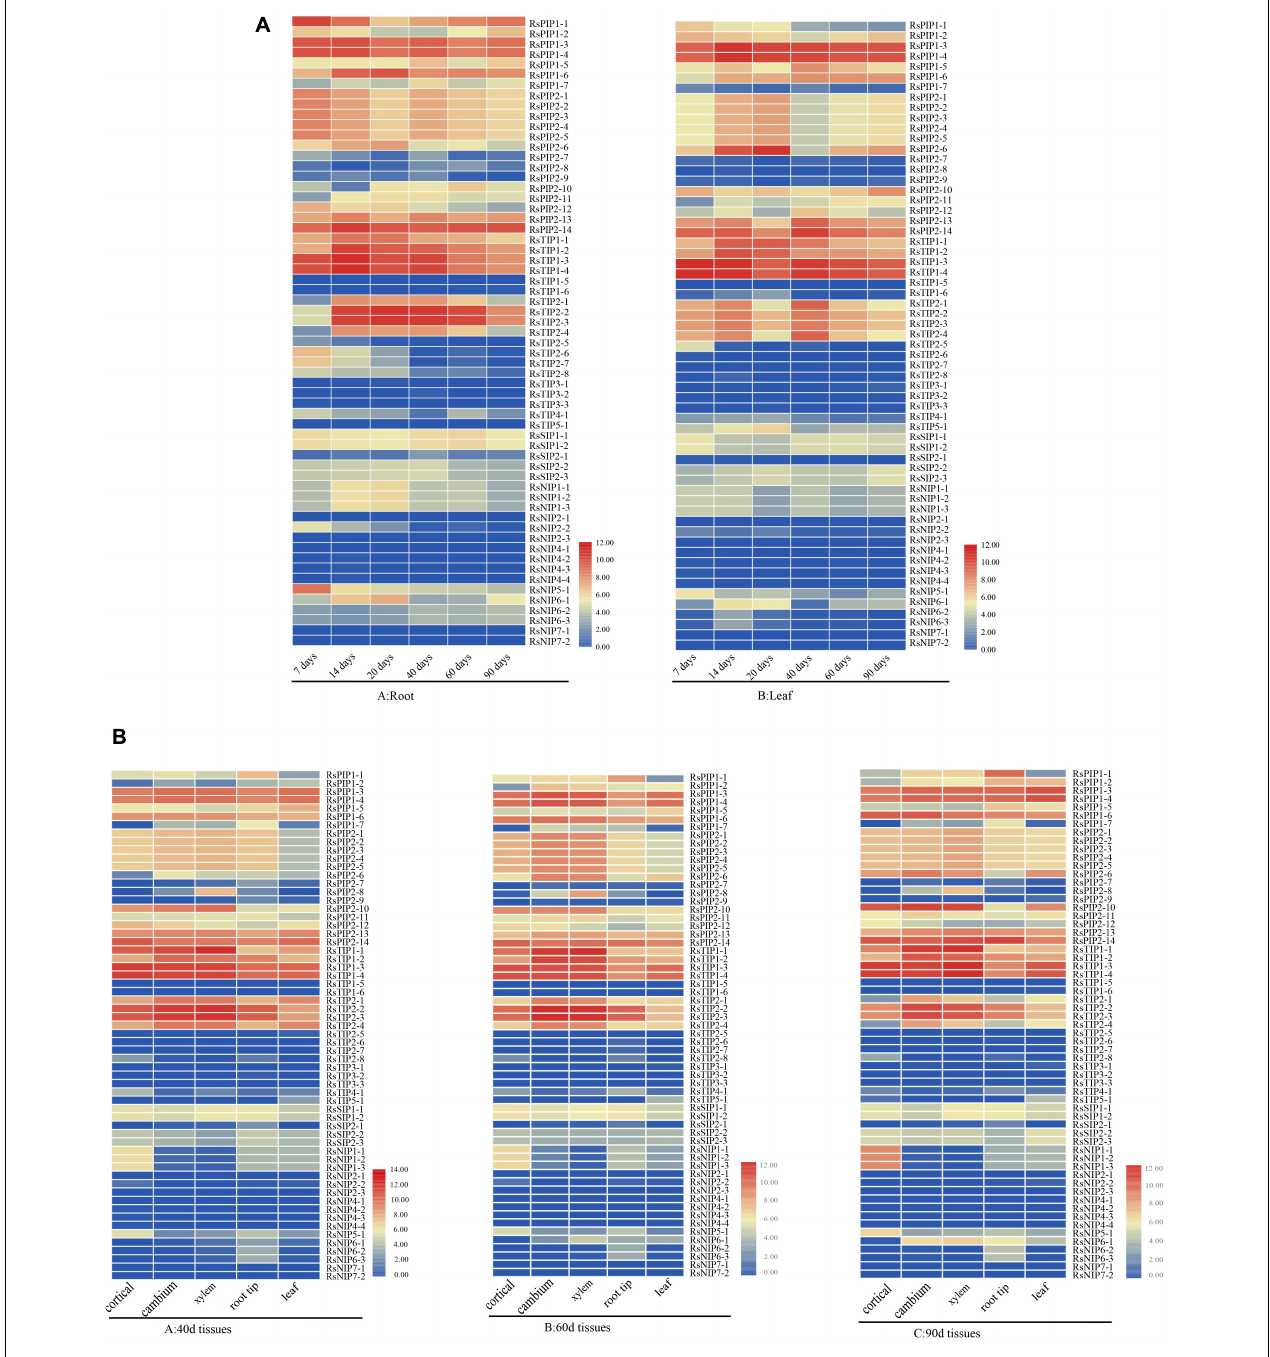
FIGURE 5 | Expression profiles of RsAQP genes in different stages and tissues. (A) RsAQP gene expression heatmap in six stages (7, 14, 20, 40, 60, and 90 days) of two tissues (root and leaf). (B) RsAQP gene expression heatmap in three stages (40, 60, and 90 days) of five tissues (cortical, cambium, xylem, root tip, and leaf).